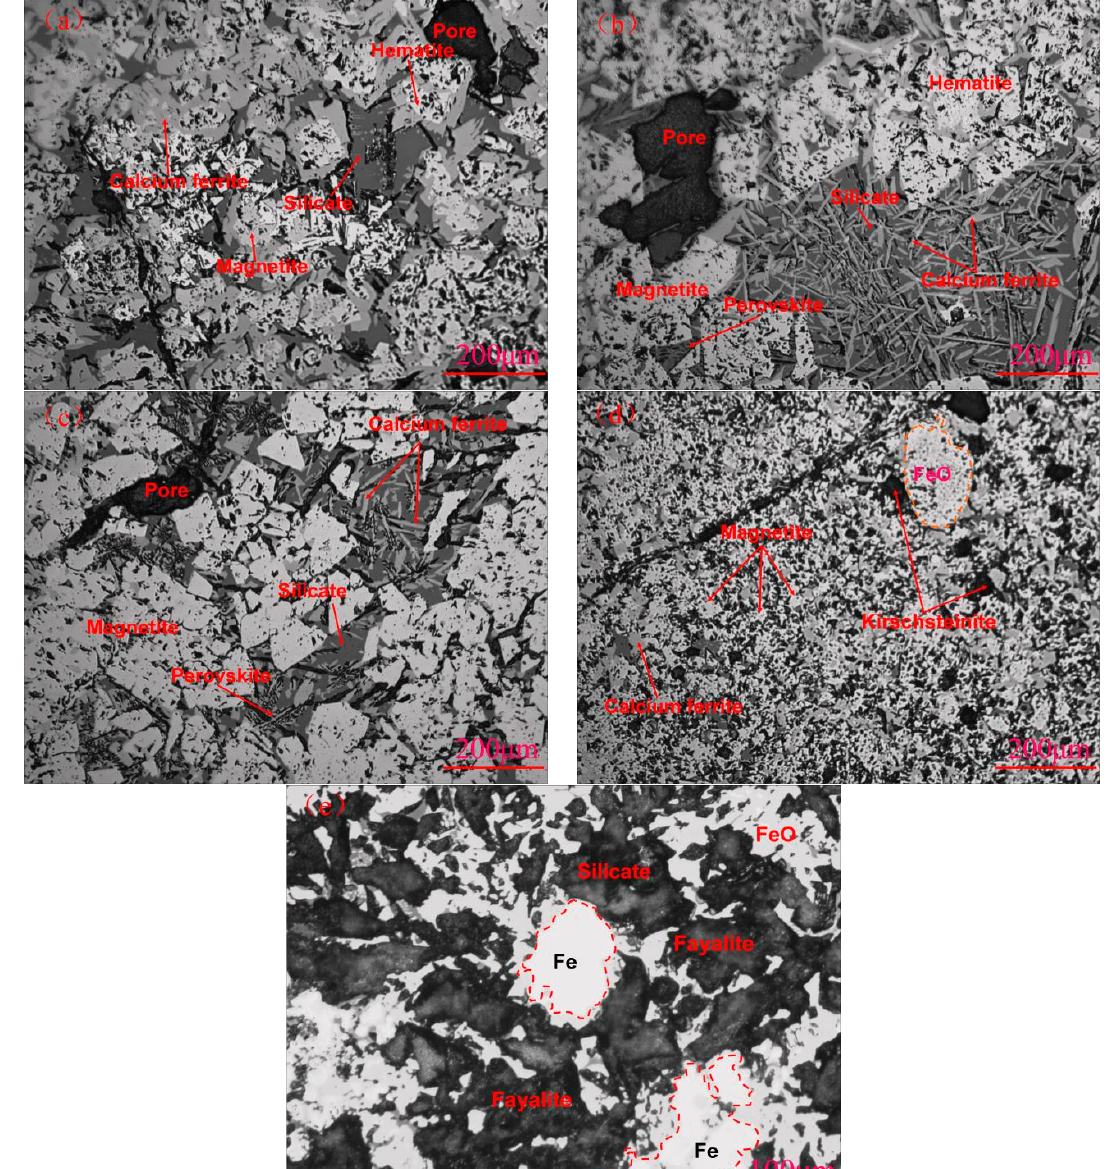
Figure 6. Mineralogy and microstructure of HCVTS at different coke ratios. ( a ) C = 4.0%; ( b ) C = 4.5%; ( c ) C = 5.0%; ( d ) C = 5.5%; and ( e ) C = 6.0%. ( c ) C = 5.0%; ( d ) C = 5.5%; and ( e ) C =